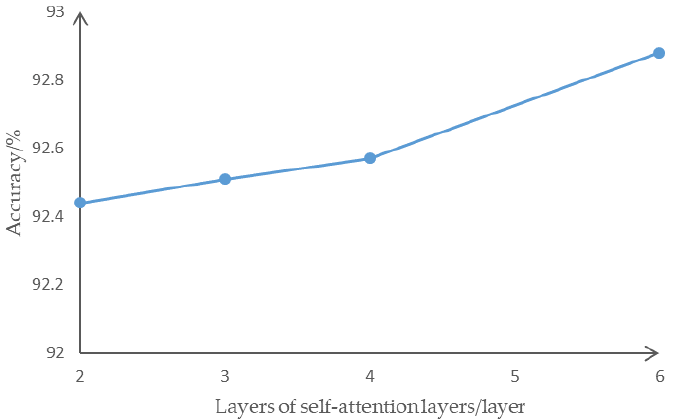
Figure 11. The prediction accuracy of different self-attention encoder layers.